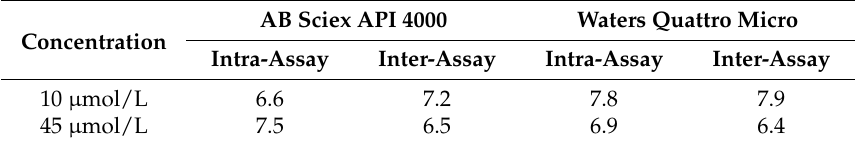
Table 1. Intra-assay and inter-assay imprecision * of tHCY at normal and abnormal concentrations. AB Sciex API 4000 Waters Quattro Micro Concentration Intra-Assay Inter-Assay Intra-Assay Inter-Assay